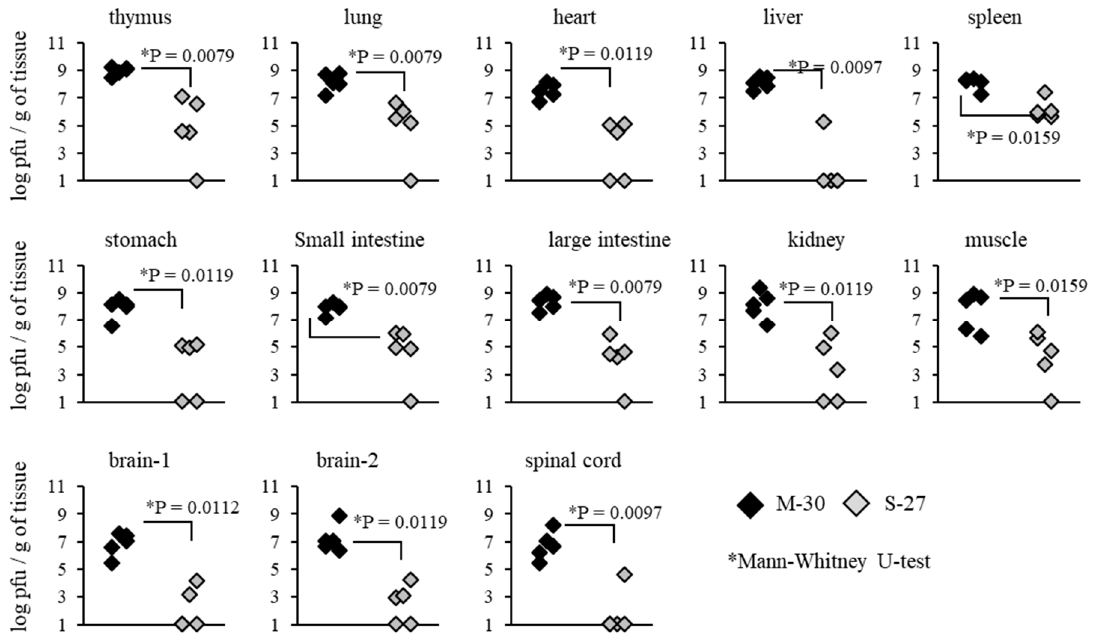
Figure 4. Viral loads in tissues of A129 mice at 3 days after subcutaneous infection with 10 2 PFU of the M-30 and S-27 CHIKV strains. The asterisks show significant differences by the Mann–Whitney U-test, P < 0.05.